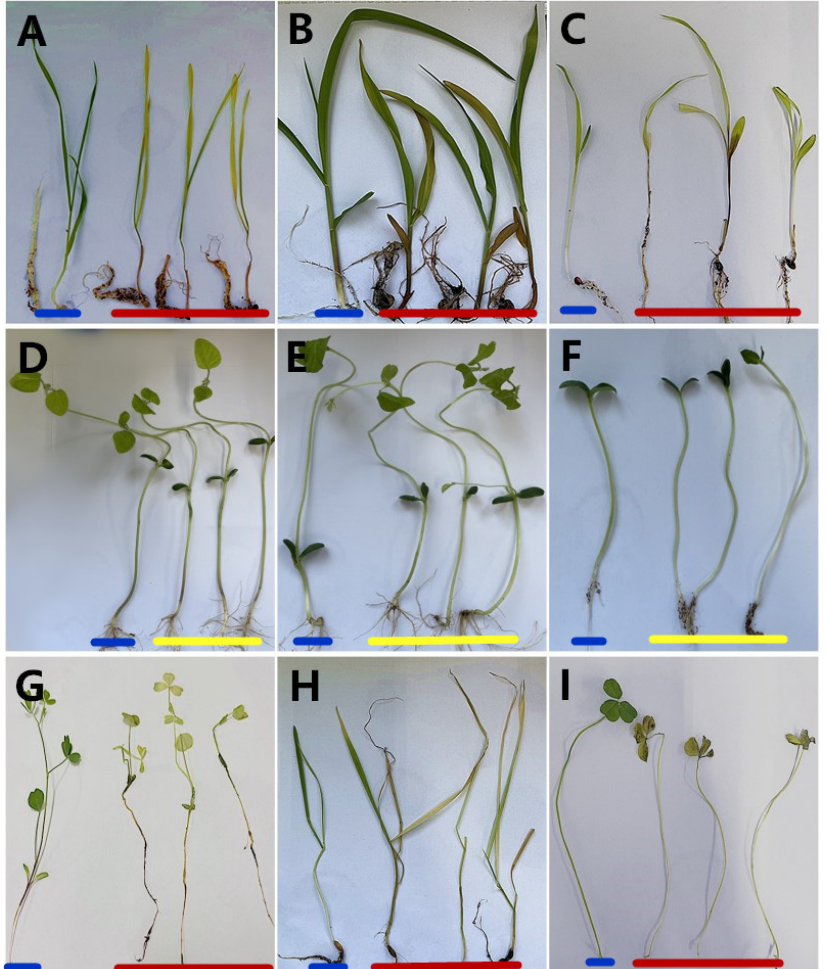
Figure 4. Pictures of various crop plant seedlings acting as either hosts or non-hosts of Pythium aristosporum . ( A ) wheat ( Triticum aestivum L.), ( B ) maize ( Zea mays L.), ( C ) sorghum ( Sorghum bicolor (L.) Moench), ( D ) soybean ( Glycine max (L.) Merr.), ( E ) black soybean ( Glycine max var. ), ( F ) cucumber ( Cucumis sativus L.), ( G ) alfalfa ( Medicago sativa L.), ( H ) oats ( Avena sativa L.), ( I ) white clover ( Trifolium repens L.), In each picture, the blue line indicates the control plant; the red line indicates the diseased plants inoculated with P. aristosporum ; the yellow line indicates the uninfected plants inoculated with P. aristosporum .